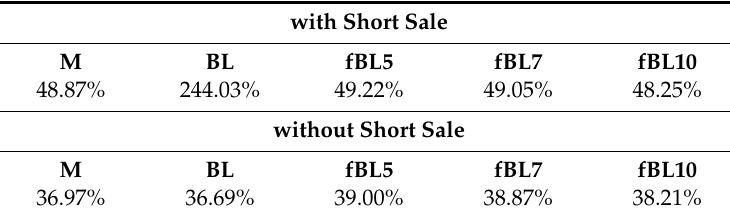
Table 3. Average monthly change in portfolio composition.